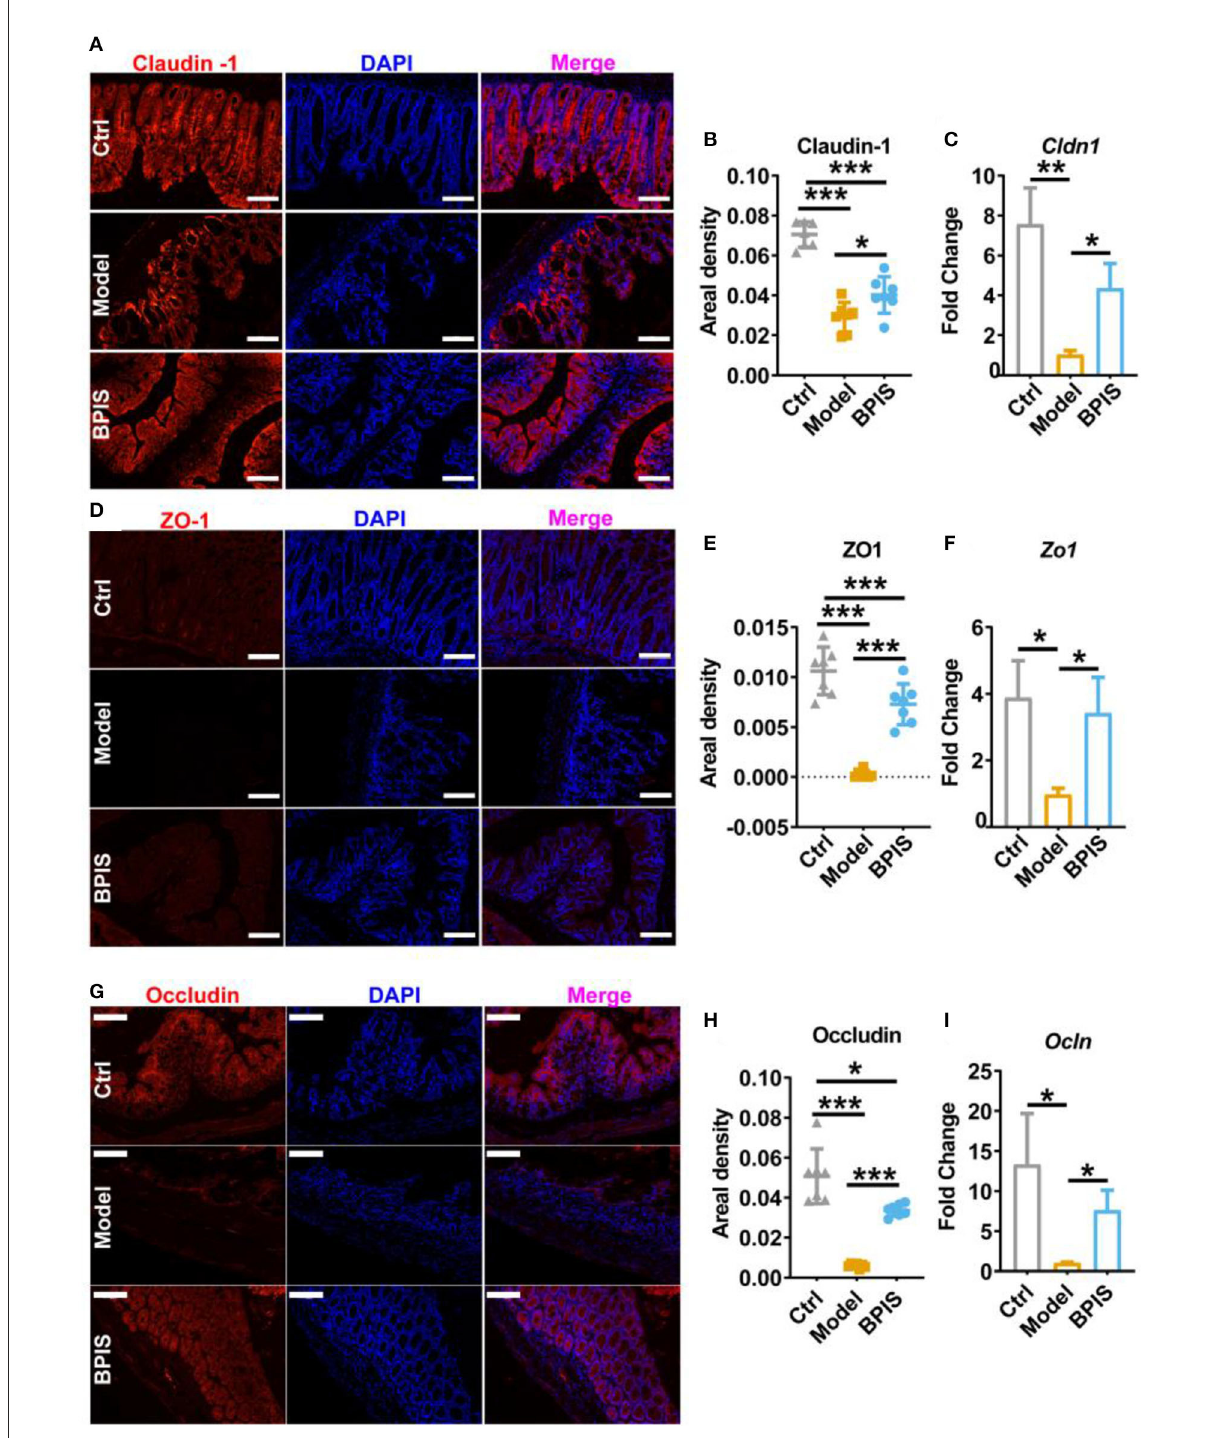
FIGURE4 BPIS inhibited the loss of epithelial barrier integrity. Representative immunofluorescence staining images of tight junction proteins Claudin-1 (A) , ZO-1 (D) , and Occludin (G) , and the positive areal density (B,E,H) and the mRNA expression encoding these proteins in colon tissues. (C,F,I) . Scale bars, 100 µ m. Data are presented as the means ± SD ( n ≥ 5) and were analyzed by an ordinary one-way ANOVA with Tukey’s multiple comparisons. * p < 0.05, ** p < 0.01, *** p <